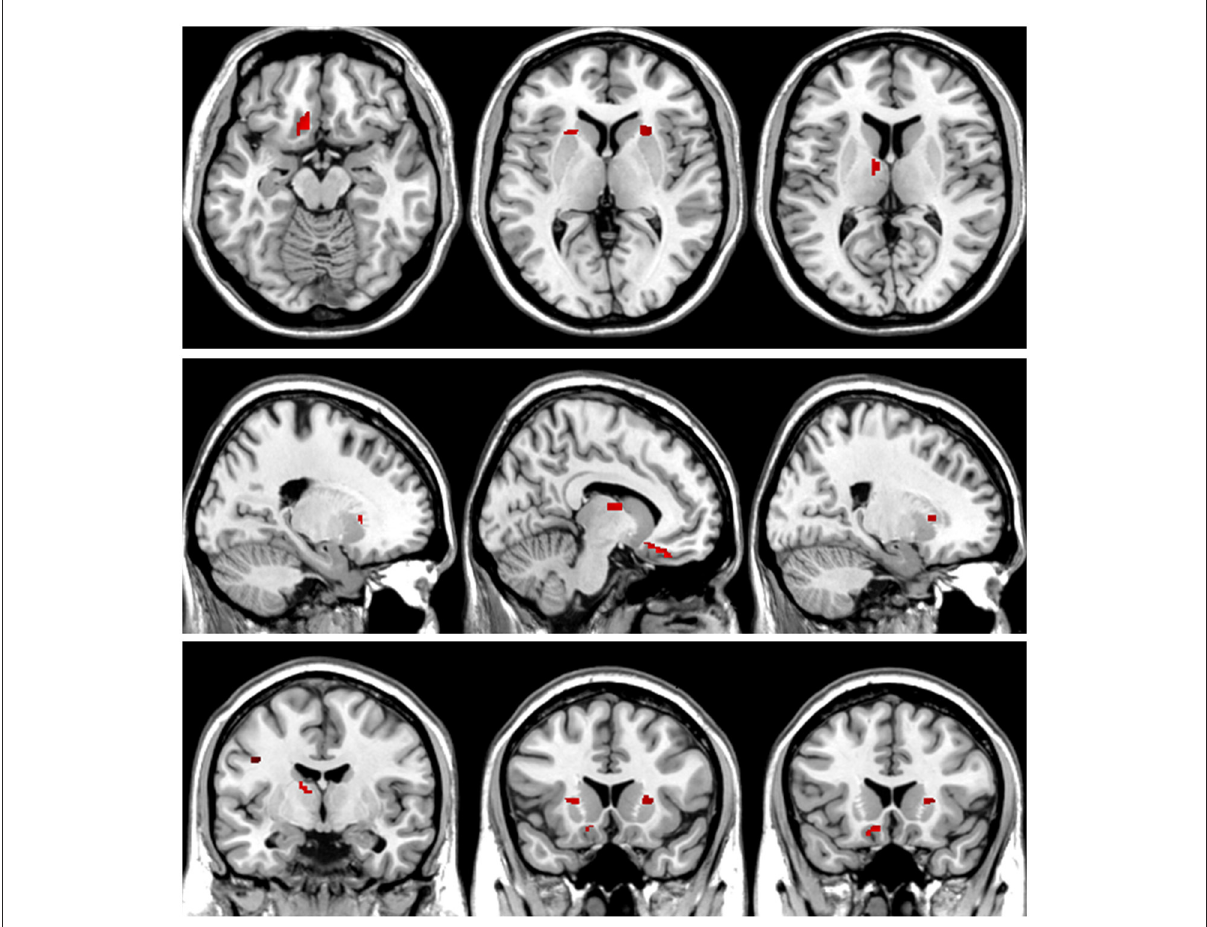
FIGURE7 T -value map of increased white matter volume in the patients with left acoustic neuroma compared with healthy controls. Compared with the healthy controls, the brain regions with increased white matter volume in the patients with left acoustic neuroma were: the bilateral putamen, left rectus, and left thalamus. The statistical threshold was voxel-wise p < 0.001 with cluster-wise FWE corrected p < 0.05 (28